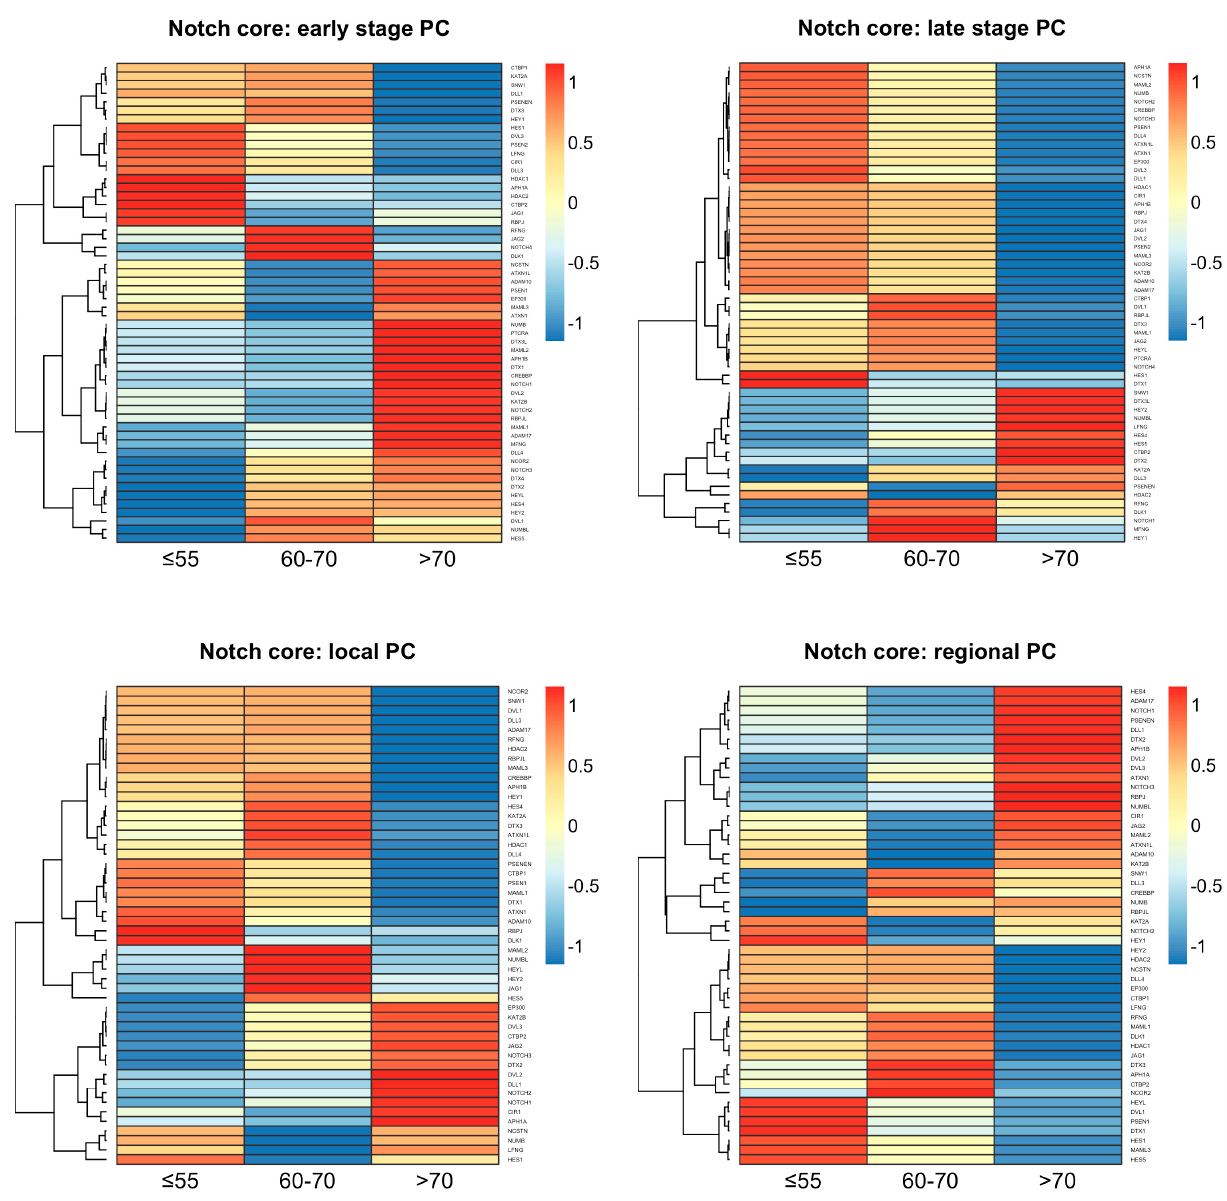
Figure 1. The profiles of core Notch signaling differentiate age subgroups of PC. Table 1. A detailed comparison of the Notch expression between tumor stages according to the age of PC onset.